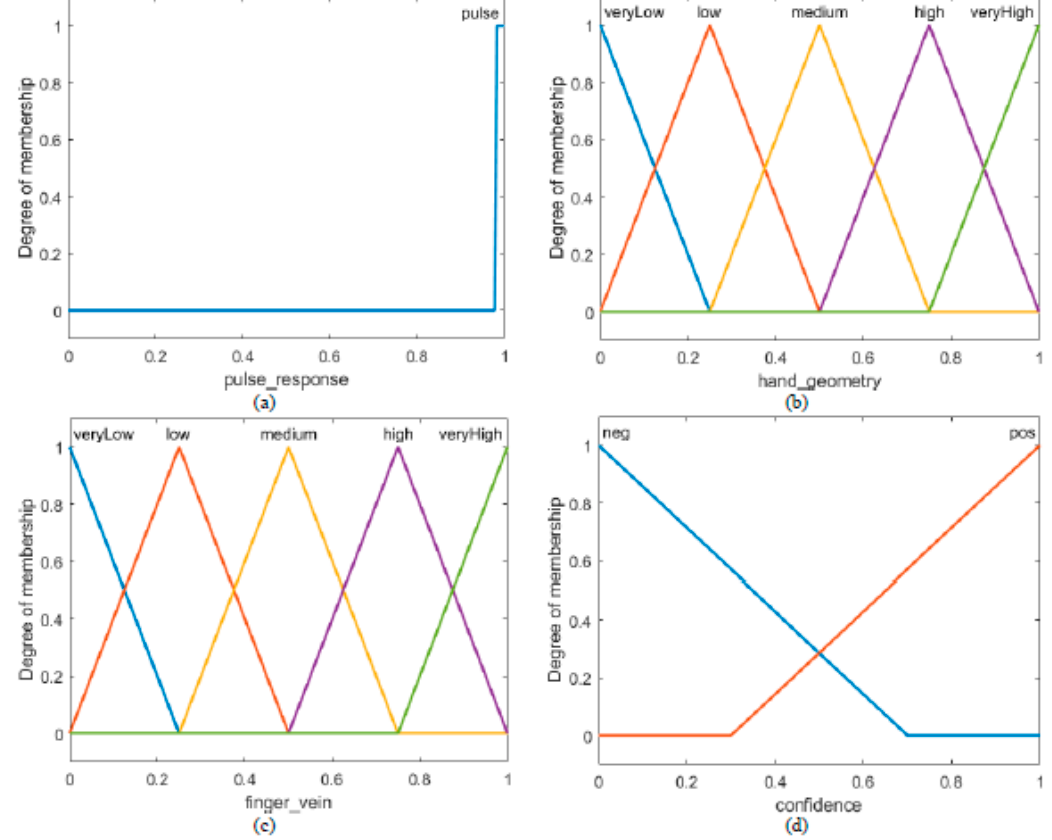
Figure 7. Fuzzification of inputs and outputs: ( a ) Fuzzification of Pulse Response System; ( b ) Fuzzification of Hand Geometry System; ( c ) Fuzzification of Finger-Vein System; ( d ) Fuzzification of the Output.